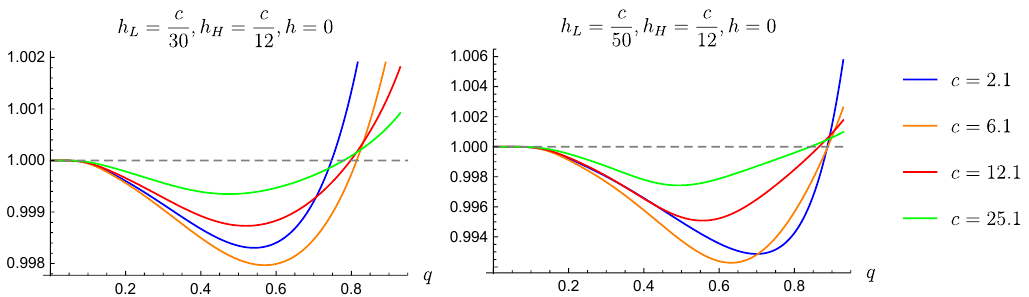
11 with c 0 c in order to test the semiclassical c log ( c 0 ;q ) 10 (cid:17) V 1, but ! 1. In the OPE limit q 0 the semiclassical (cid:0) !